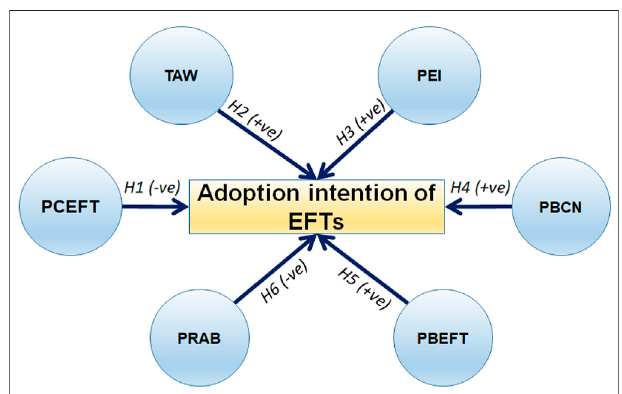
FIGURE 1 | Theoretical background and hypotheses formulation. Notes: EFTs: environmentally friendly technologies, PCEFT: perceived cost of EFTs, TAW: technological awareness, PEI: perceived environmental importance, PBCN: perceived behavioral control, PBEFT: perceived bene fi ts of EFTs, PRAB: perceived risk-averse